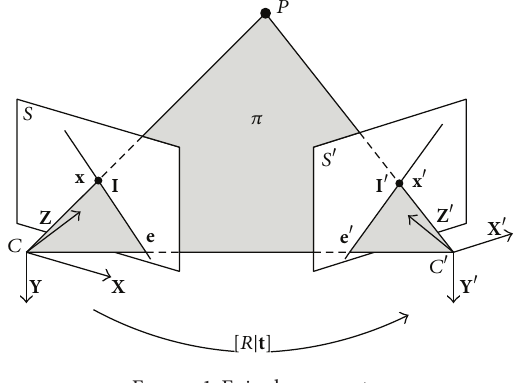
Figure 1: Epipolar